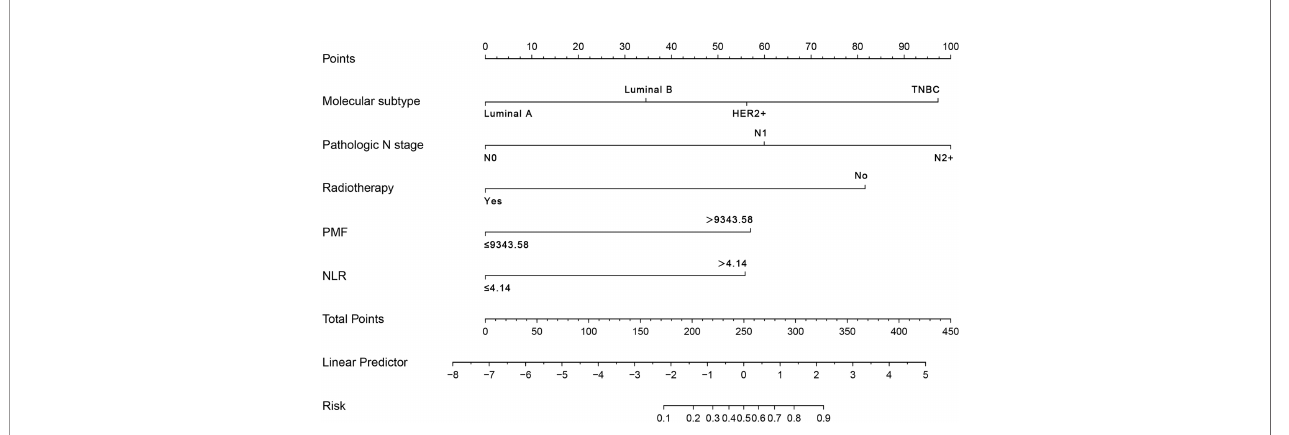
FIGURE 4 | Nomogram model predicts the probability of local – regional recurrence. Points refers to point for the individual risk factor and add together to the total points. Luminal A, HER-2 ( − ), ER (+), PR (+) and high expression, Ki67 low expression; Luminal B, HER-2 ( − ), ER (+), PR ( − ) or low expression, Ki67 high expression; HER2+, the breast cancer of HER2 positive; TNBC, triple-negative breast cancer; N0, No positive lymph nodes; N1, the number of positive lymph nodes is 1 – 3; N2 +, the number of positive lymph nodes is more than 3; PMF, platelet count*mean platelet volume* fi brinogen; NLR, neutrophil count-to-lymphocyte count ratio.